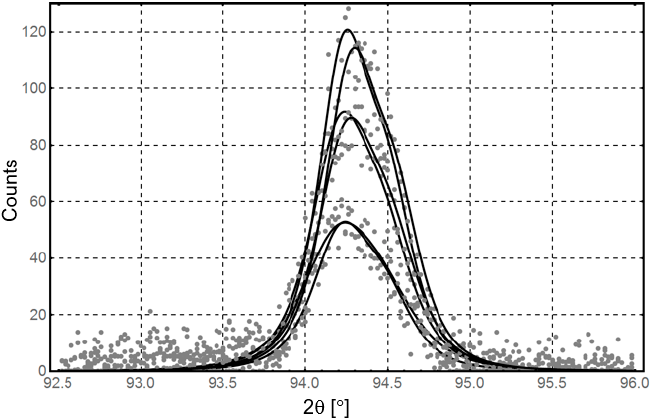
Figure 10. Distribution of intermediate results of one measuring direction for AA2519 alloy.